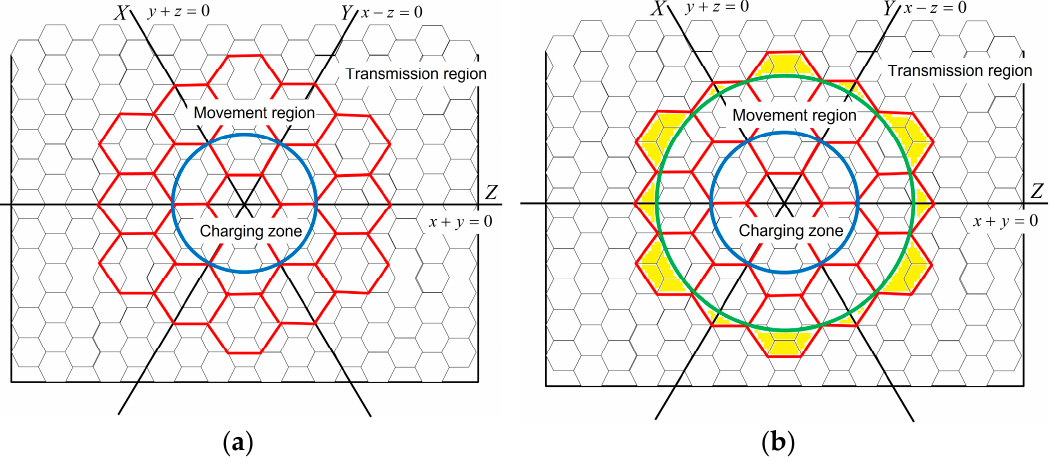
Figure 4. ( a ) Two coordinate systems overlapping at the origin; ( b ) Intersection of the movement and transmission regions.